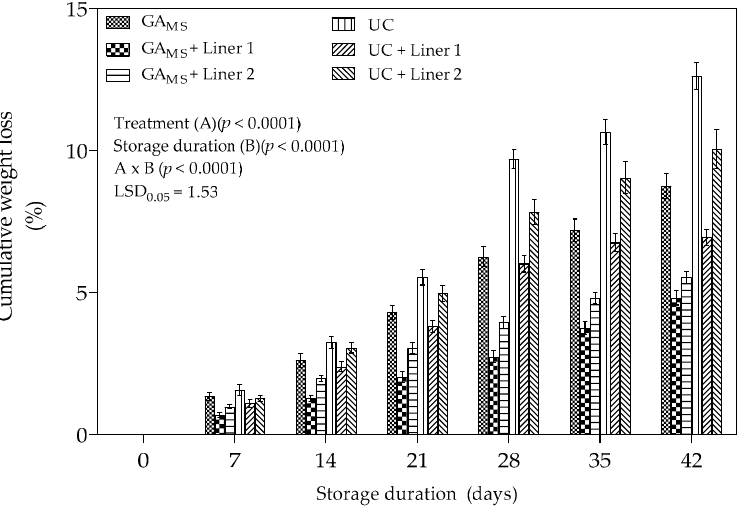
Figure 2. Cumulative weight loss (%) of ‘Wonderful’ pomegranate coated and packaged in different polyliners and stored (5 ± 1 °C, 95 ± 2% RH) for 42 d. GA MS —gum Arabic (0.5% w / v ) and maize starch (0.5% w / v ); Liner 1—Xtend ® liner (20 µmm perforations); Liner 2—perforated liner (4 mm perforations); UC—uncoated fruit. LSD 0.05 represents least significant difference ( p < 0.05).